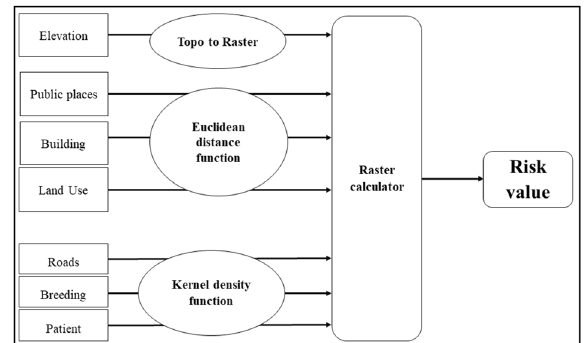
Figure 5. Systematic flow chart of risk model